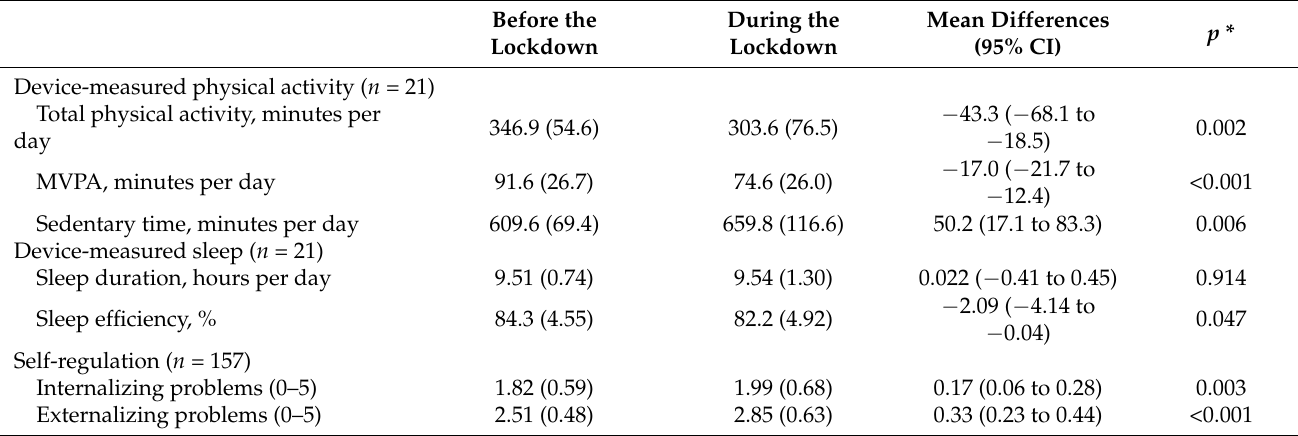
Table 2. Changes in physical activity, sedentary time, sleep and psychosocial parameters before and during the coronavirus disease 2019 (COVID-19) lockdown in those preschoolers participating in the two evaluations. Before